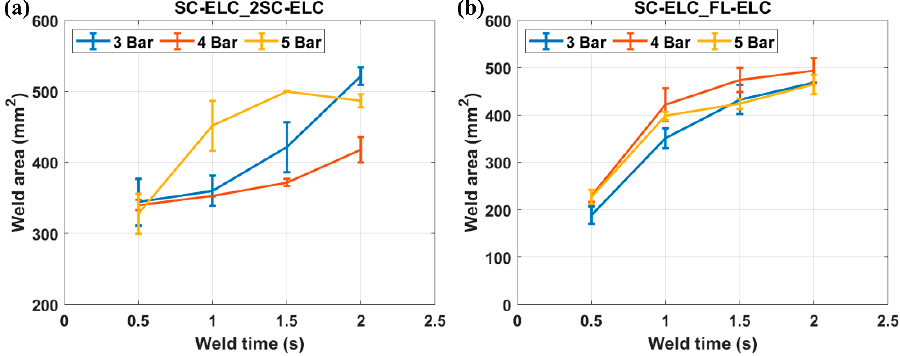
Figure 12. Welded area under all the welding conditions for ( a ) SC-ELC_2SC-ELC ( b ) SC-ELC_FL- ELC.